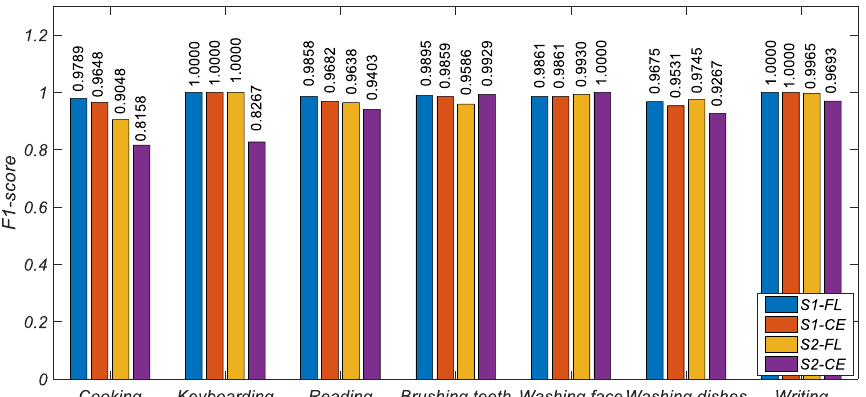
Figure 7. The recall comparison of HAR-CE and HAR-FL in each class.